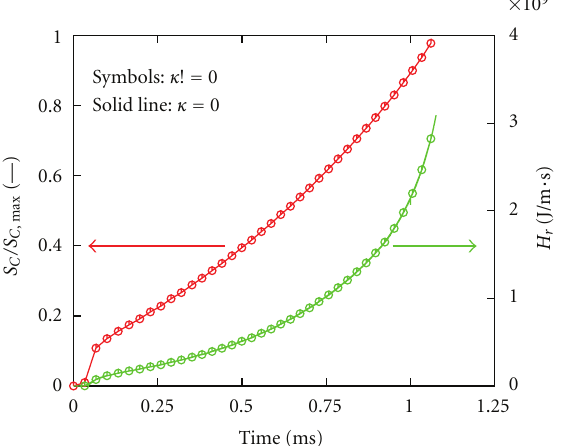
Figure 5: Temporal evolution of the laminar fuel consumption and integrated heat release rates for Case 0 with (circle points) and without (solid line) volume viscosity.